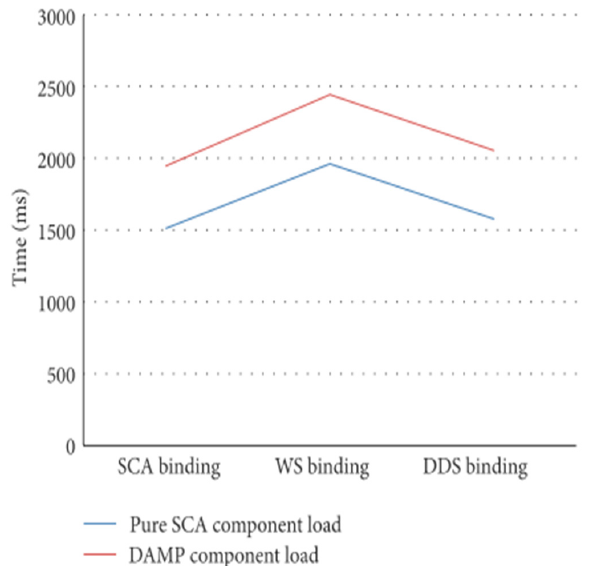
Figure 15 . DAMP vs. SCA (Tuscany) overhead.